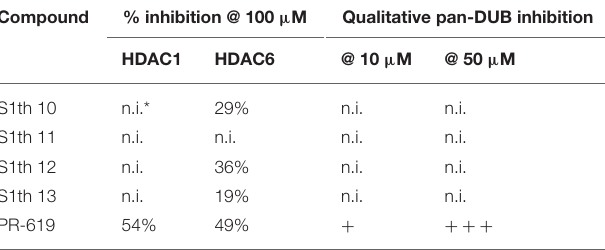
TABLE 4 | Selectivity over histone deacetylases and deubiquitinases compared to pan-DUB inhibitor PR-619.